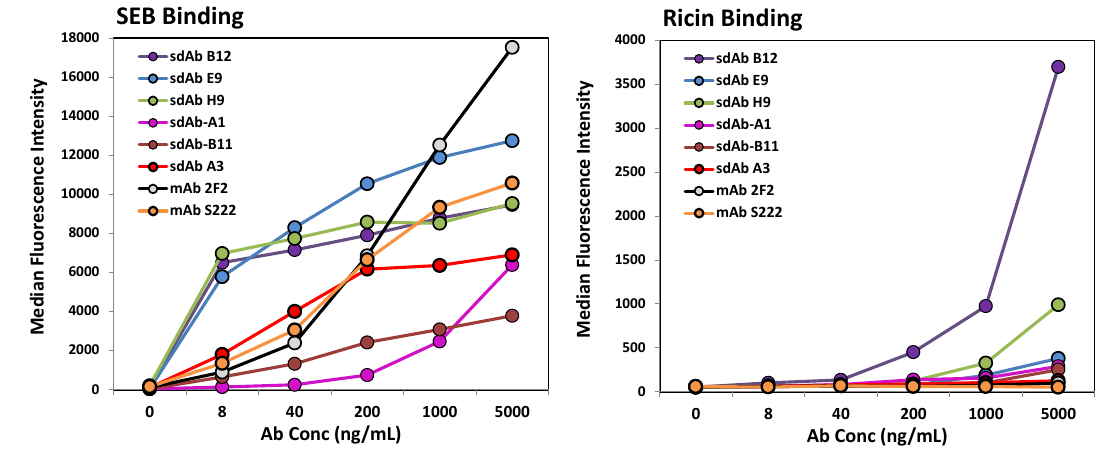
Figure 4. SEB direct-binding assay for selected sdAbs and mAbs (collectively termed Abs). SEB and ricin were cross-linked onto MagPlex microspheres. Biotinylated Abs were added at the concentrations shown. Fluorescence detection carried out upon addition of streptavidin-phycoerythrin. The error (SEM) was less than 10% for all